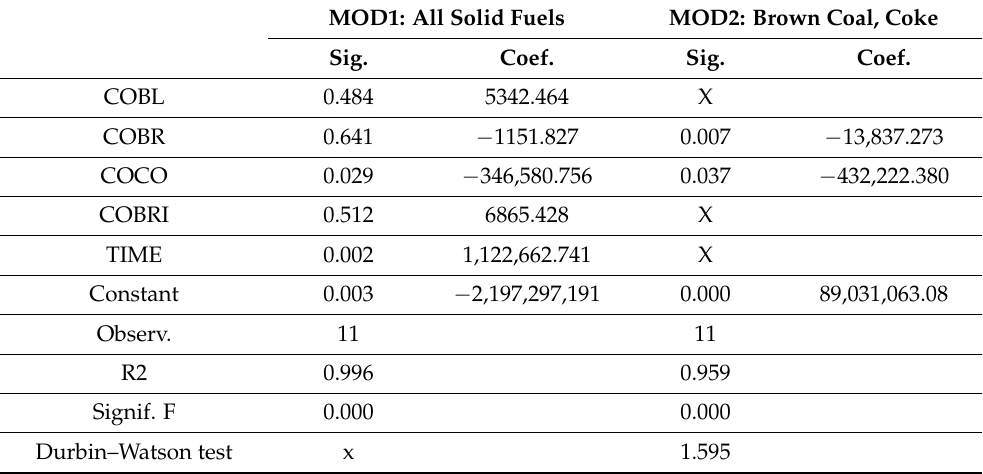
Table 5. Regression analysis—substitution model. MOD1: All Solid Fuels MOD2: Brown Coal, Coke Sig. Coef. Sig.